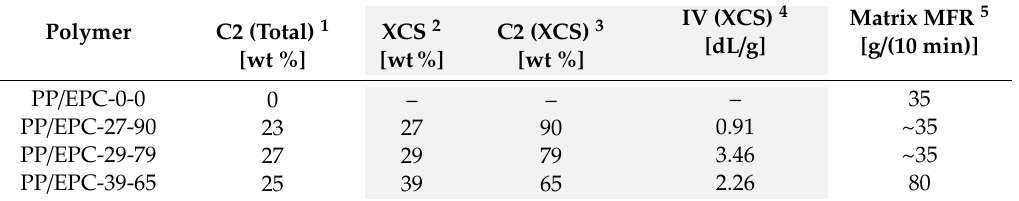
Table 1. Molecular Characteristics of the Samples of the Present